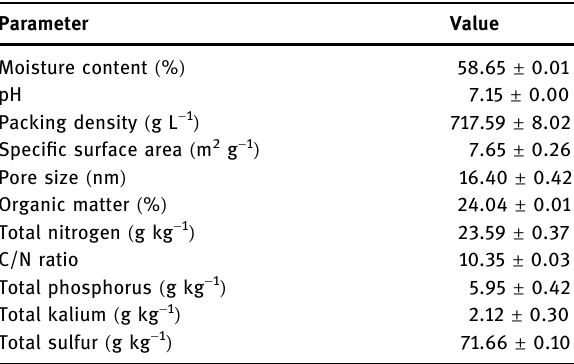
Table 1: Physical and chemical properties of the vermicompost values are the means ± standard errors ( n = 3 )